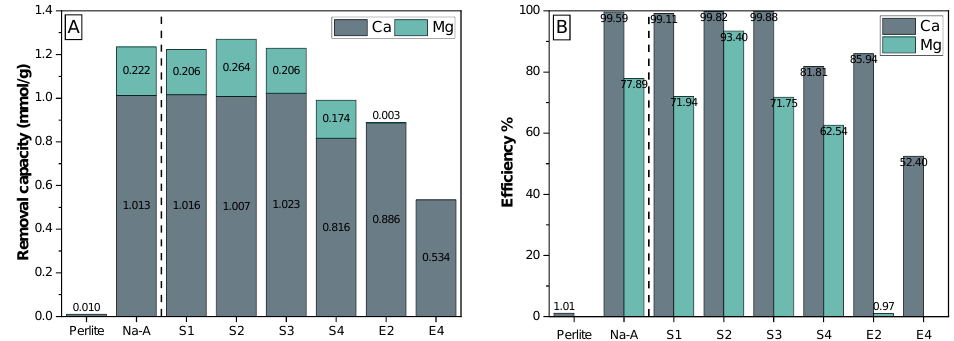
Figure 8. ( A ) Removal capacity for Ca 2+ and Mg 2+ ions by synthetic GIS- (E1), SOD- (E2) and LTA- zeolites (S1–S4) from Graz tap water. Perlite powder and commercial zeolite A (Na-A) are included as a reference. ( B ) Removal efficiencies for Ca 2+ and Mg 2+ ions measured at ion exchange equilibrium with Graz tap water, demonstrating the applicability of the zeolites for water softening